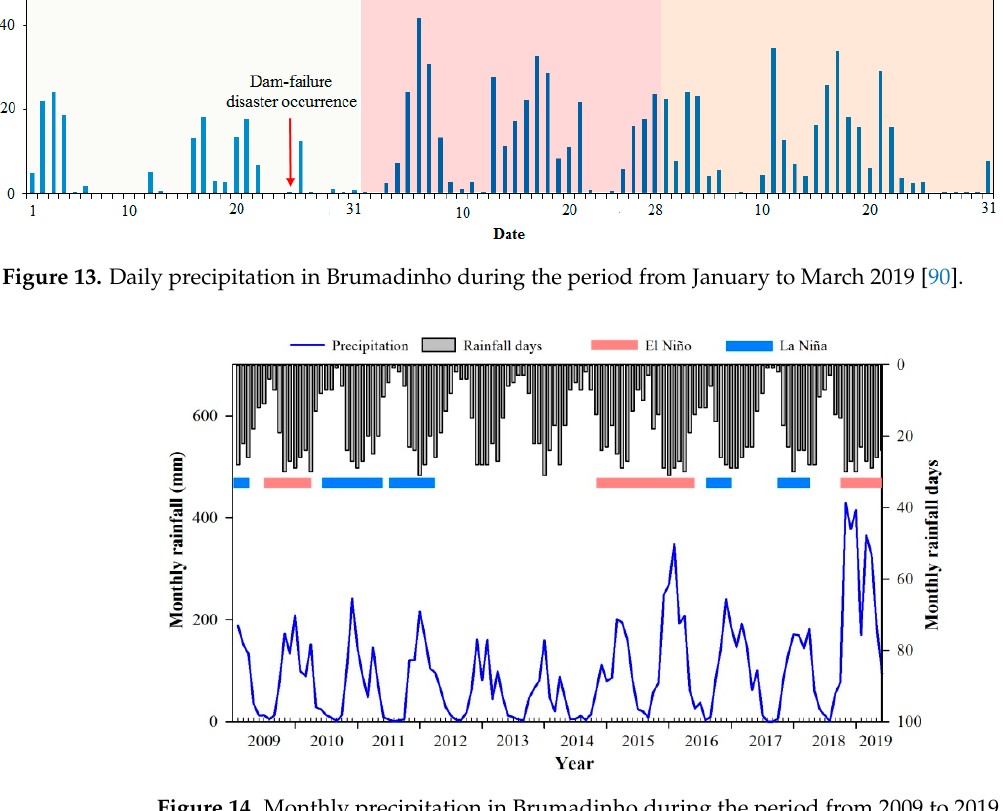
Figure 14. Monthly precipitation in Brumadinho during the period from 2009 to 2019